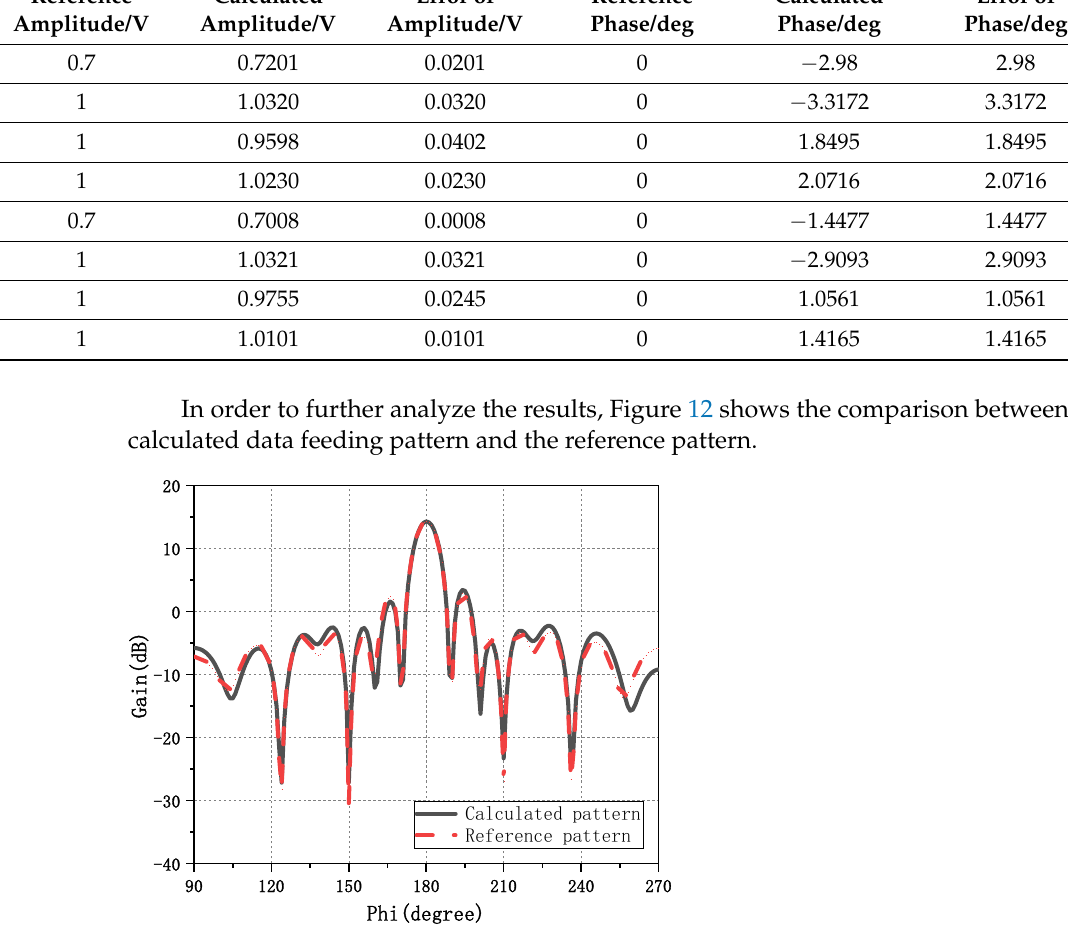
Figure 12. Comparison between the calculated pattern and the reference pattern. The calculated amplitude error of all units is less than 0.05 V, and the phase error is less than 5°. Taking the calculated amplitude and phase as the excitation input model of the phased array antenna, it can be seen that the calculated pattern is essentially consistent with the reference pattern. The above experiments show that the method is effective and can be applied to broadband antenna arrays. The specific comparison between the SWEMF method and other methods is given in Table 3. Table 3. Comparison of different methods. Number of Measurements